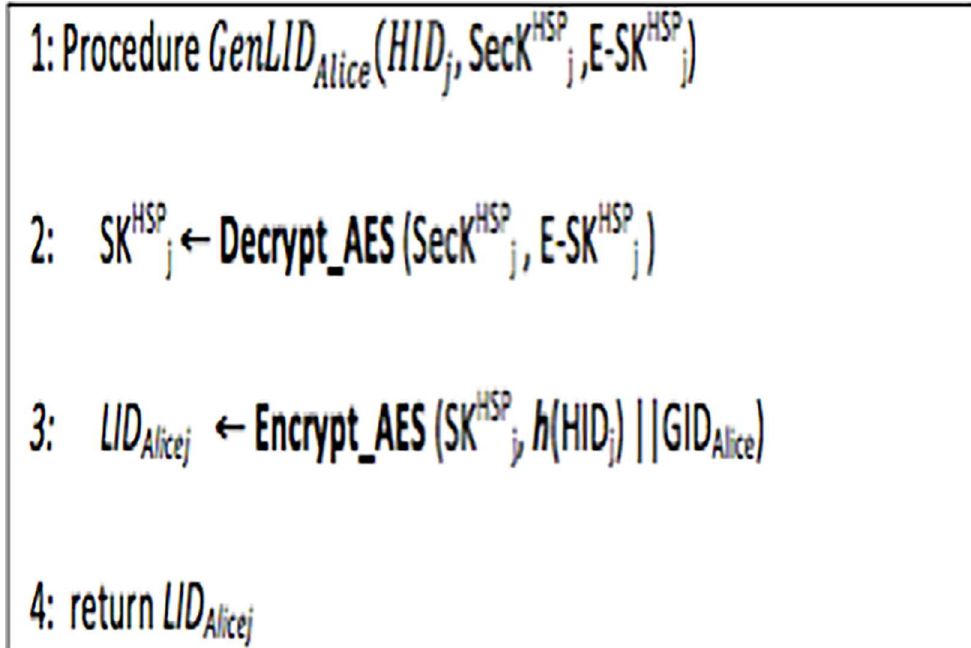
Fig 2. Algorithm 2: Generation of LID Alicej